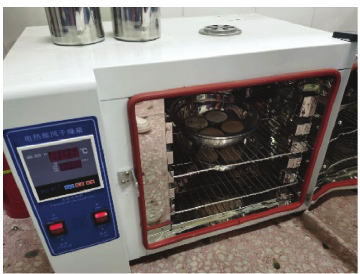
Figure 3: Constant temperature